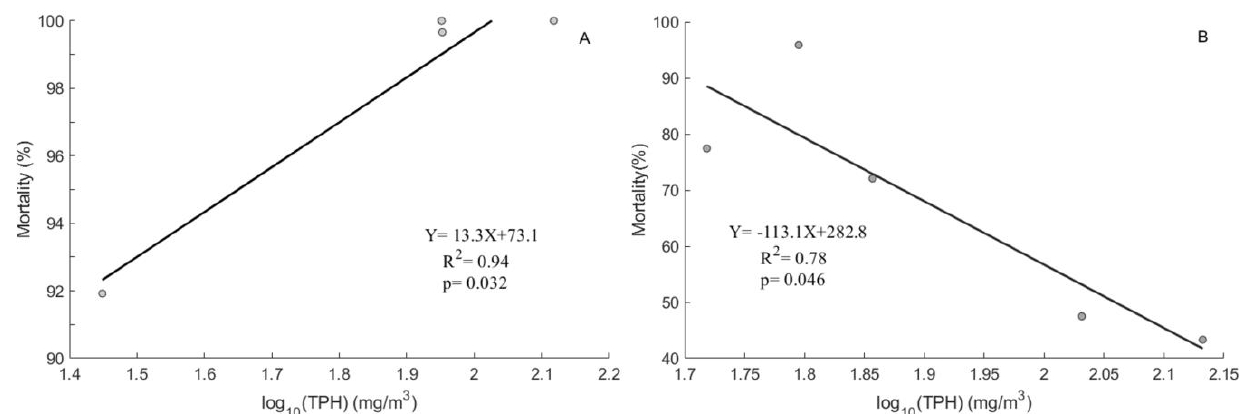
Figure 5. Relationship between the TPH and the Mortality of fish larvae ( A ), shellfish ( B ). The concentration of TPH is reduced by natural logarithm.